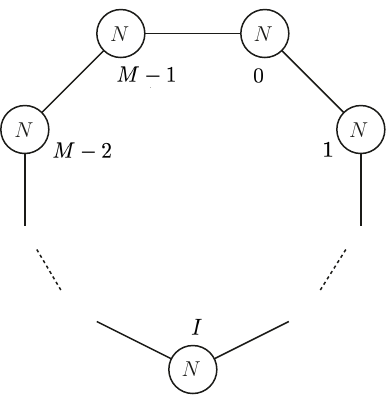
Figure 1 . A graphical representation of the quiver theory with M nodes. Each node, labeled by an index I = 0 , 1 , . . . , M − 1 , stands for a SU( N ) factor with its adjoint vector multiplet. The lines connecting two neighboring nodes represent bi-fundamental matter